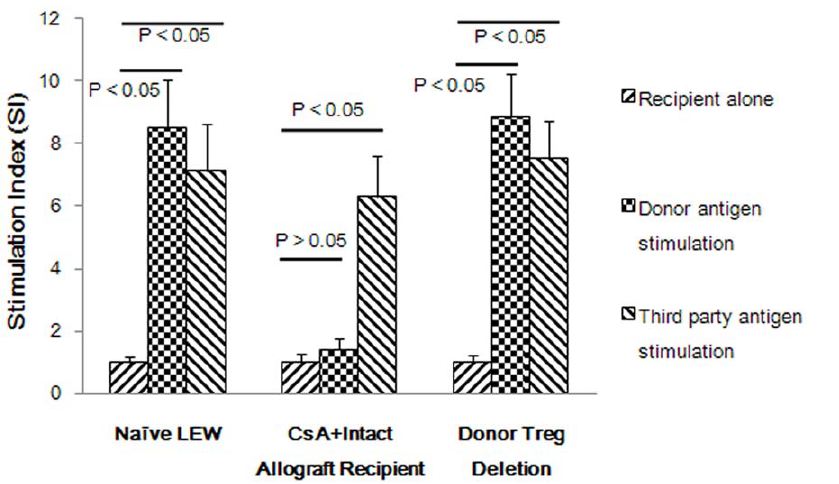
Figure 7. One-way MLR revealed a critical role of donor-specific FoxP3 + Tregs for the maintenance of tolerance. Baseline levels were assessed when naı ¨ ve Lewis splenic cells were used as responders. Hyporeactivity to donor antigen stimulation and immunocompetence for third- party antigens stimulation (ACI rats) in recipients of group 5 at POD 100 was demonstrated. When donor-specific FoxP3 + Tregs were depleted from the responder populations, robust antidonor alloreactivity reappeared.